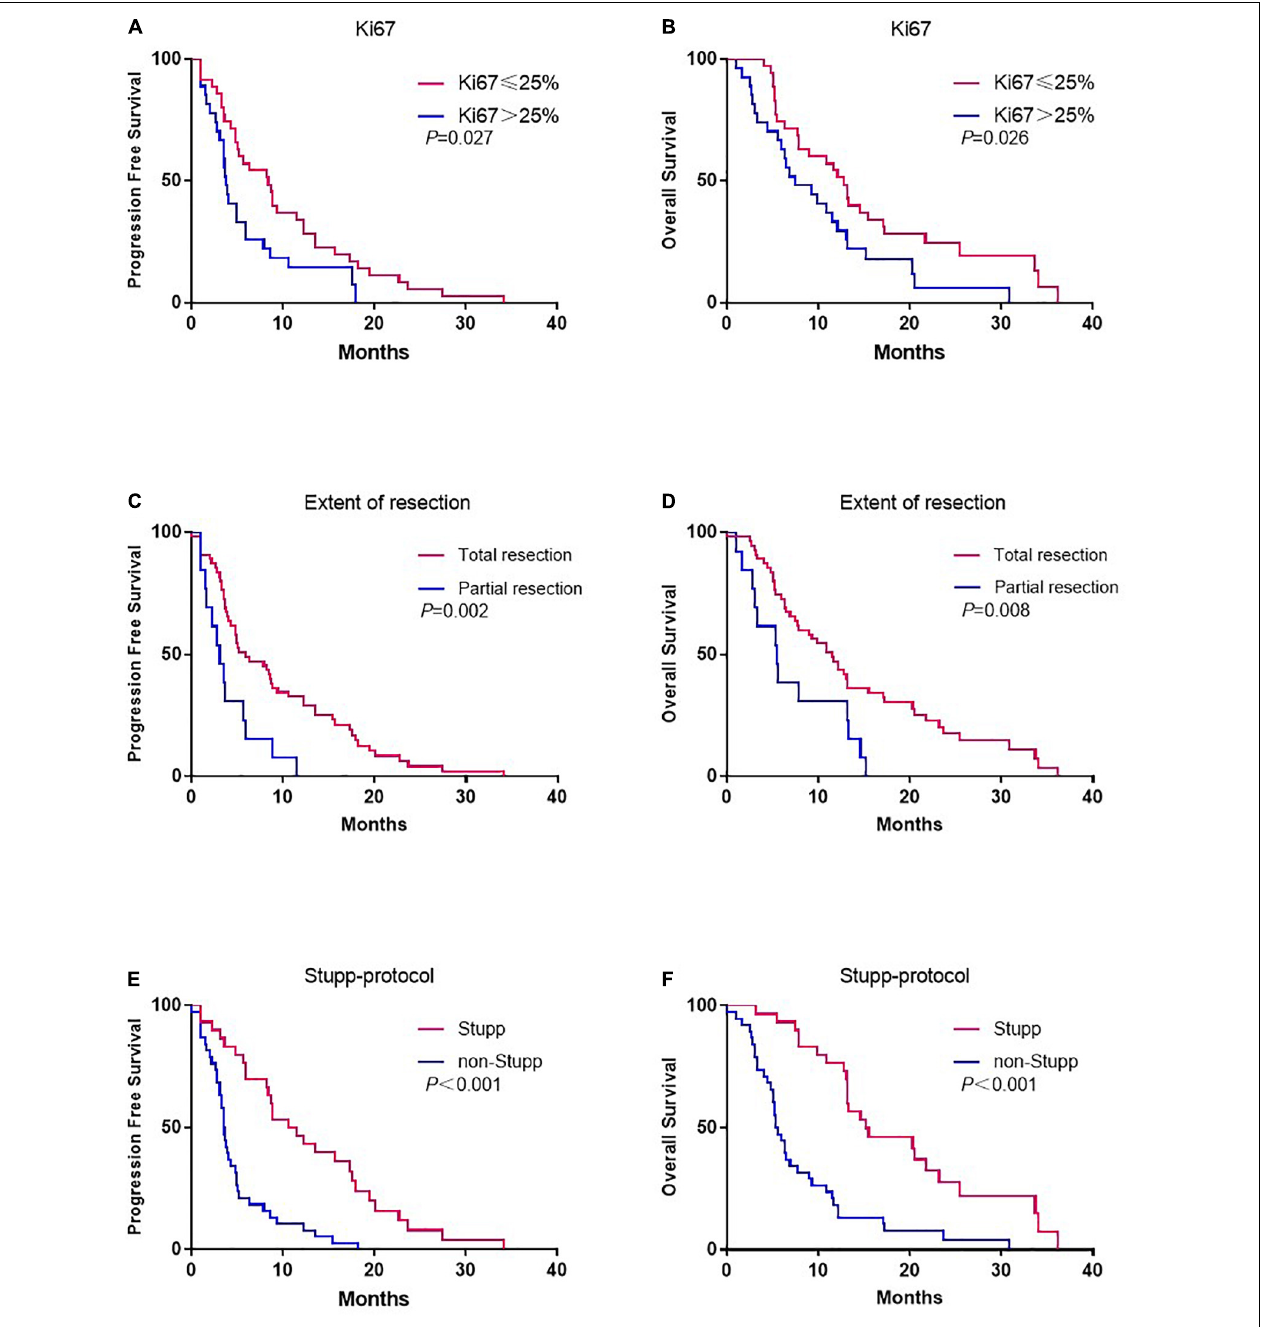
FIGURE 1 | Kaplan-Meier estimates of progression-free survival and overall survival stratified by Ki67 (A,B) , extent of resection (C,D) , and Stupp-protocol (E,F)